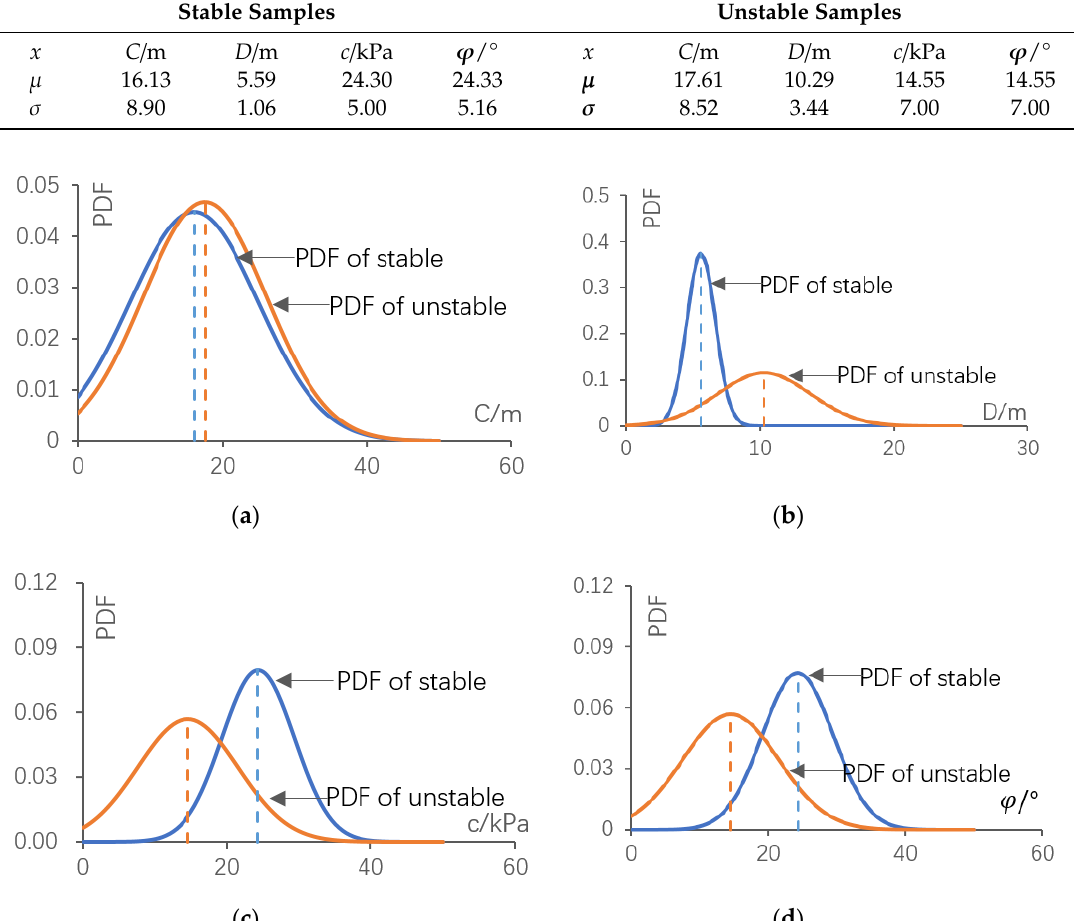
( b ) Figure 10. Error estimation for the second classifier. ( a ) Stable probability of the samples with 𝐹 𝑠 ≥ 1 ; ( b ) unstable probability of the samples with 𝐹 𝑠 < 1 . To check the validation of the constructed classifiers, 50 new samples were randomly chosen and labeled according to strength reduction analyses. The calculated stable or unstable probabilities of the samples are plotted vs. the simulated safety factors and shown in Figures 11 and 12. As can be seen, most of the test samples can be correctly classified, and the 2nd classifier performs much better than the first one regarding both stable and unstable samples. This is consistent with the conclusion obtained from the error estimations of the two classifiers using the training dataset.